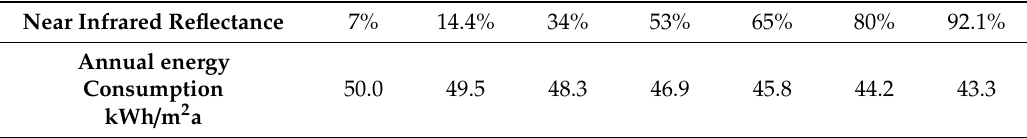
Table 4. Energy consumption simulation results.